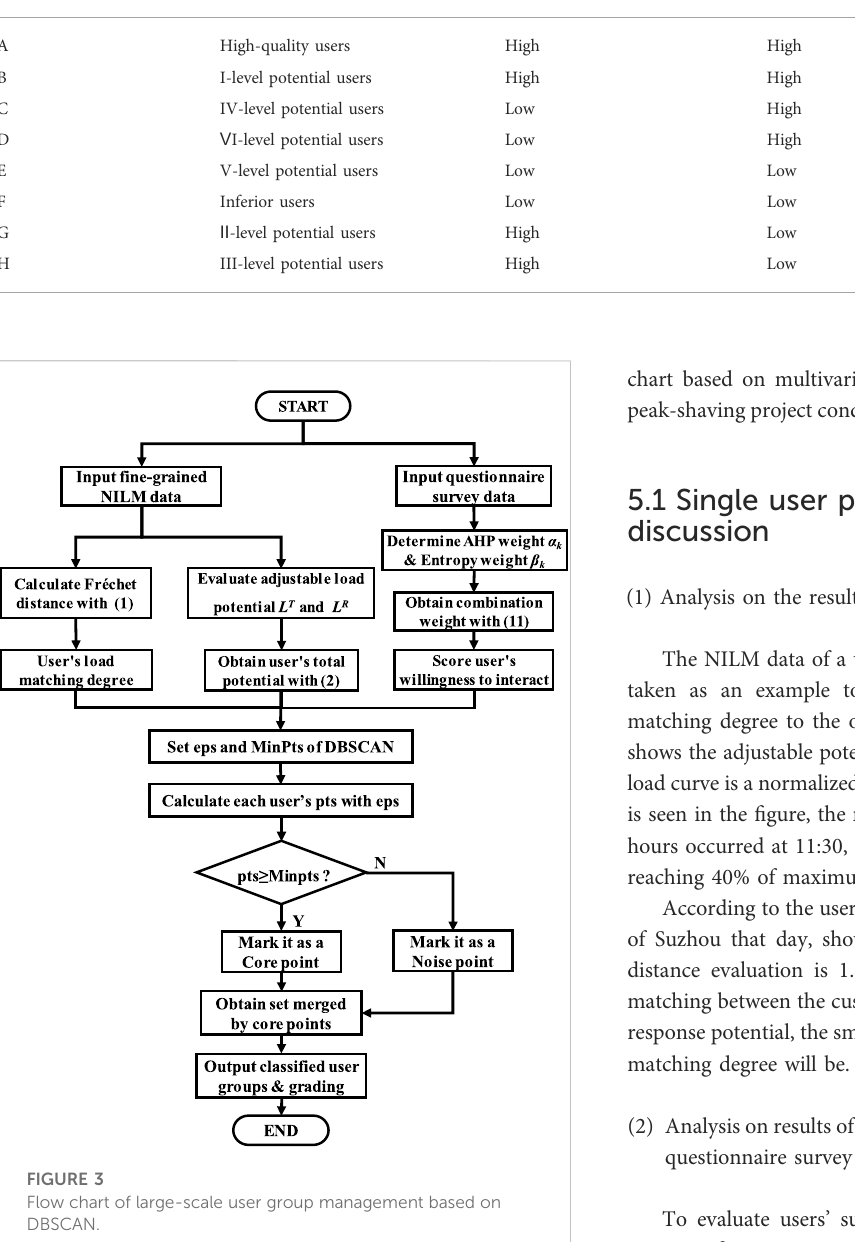
FIGURE 3 Flow chart of large-scale user group management based on